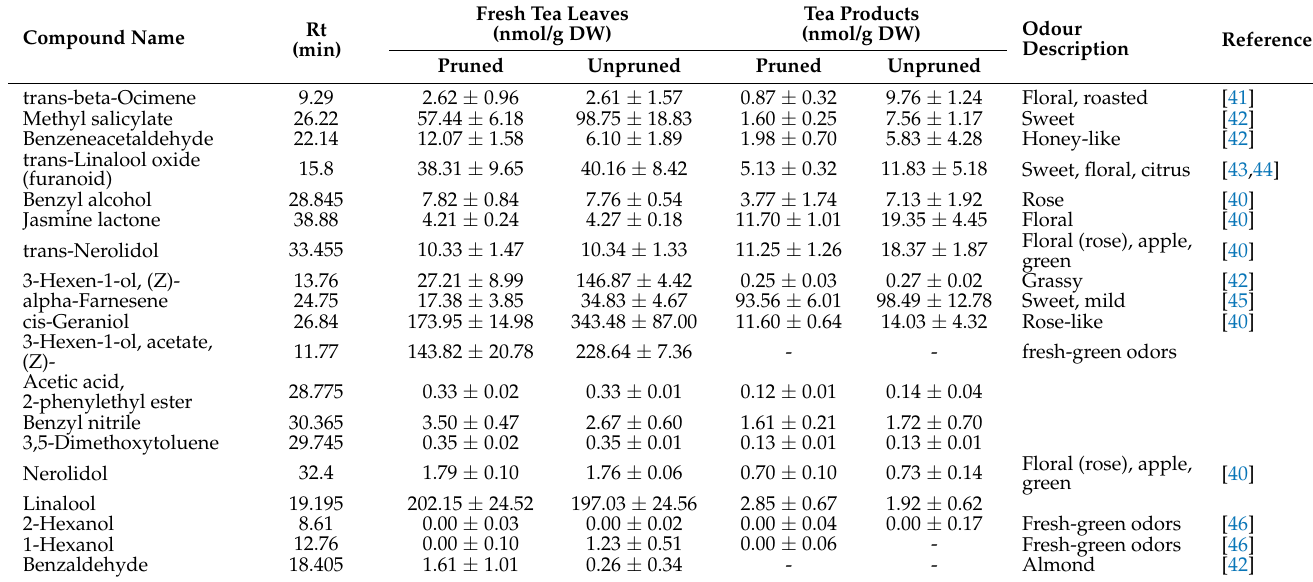
Table 2. Concentrations of volatile compounds in fresh tea leaves and tea products from long-term unpruned and pruned ‘Dancong’ tea